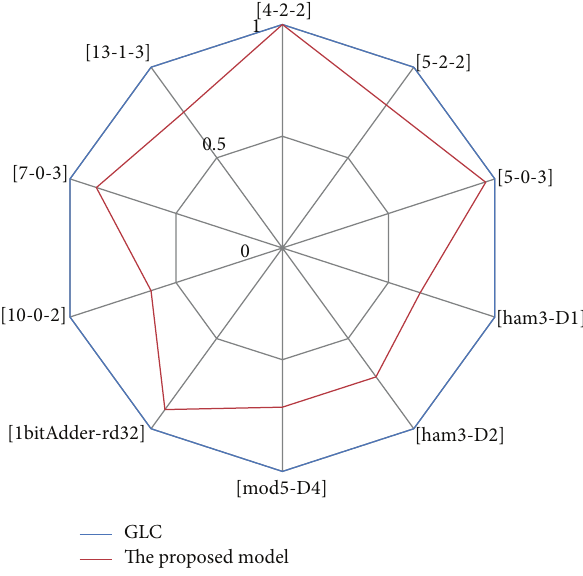
Figure 9: Improvement in the latency ( 𝜇 s) of the benchmarks achieved by the proposed